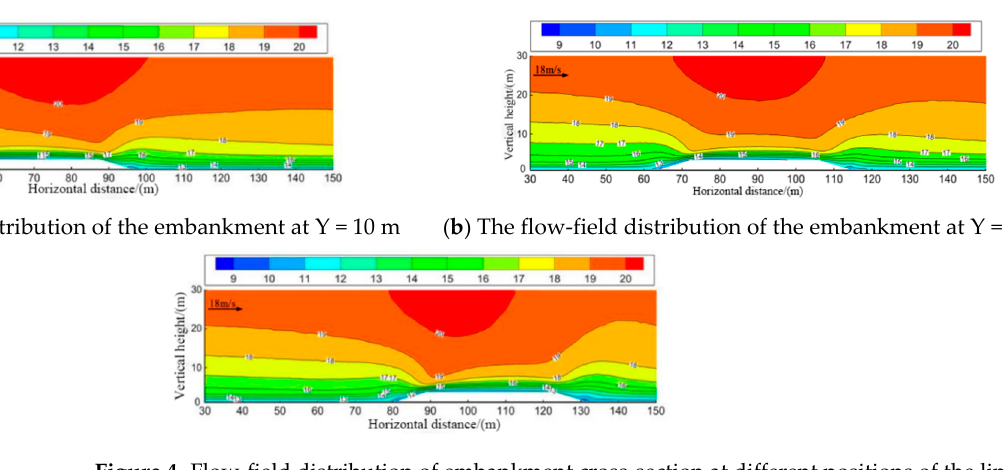
Figure 4. Flow-field distribution of embankment cross-section at different positions of the line when α = 50°.